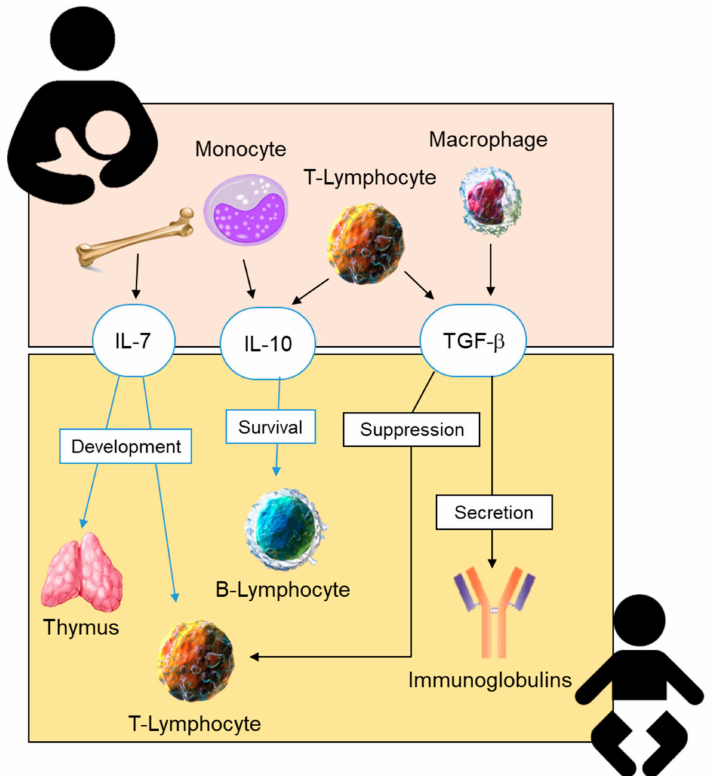
Figure 2. Site of synthesis of anti-inflammatory cytokines present in human breastmilk, and their e ff ects on the neonatal immune system. IL-6, interleukin-6; IL-10, interleukin-10; TGF- β , transforming growth factor- β